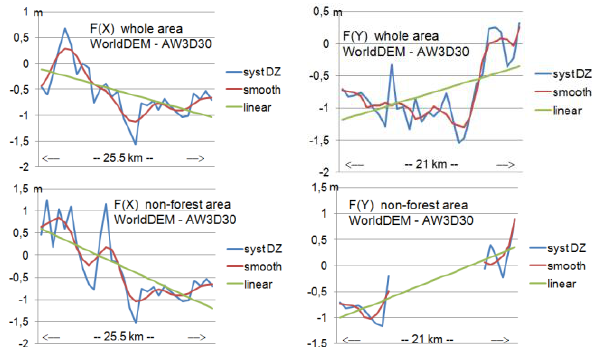
Fig. 16: Systematic errors of WorldDEM against AW3D30 as function of X (left) and Y (right) for whole (above) and non- forest area (below)